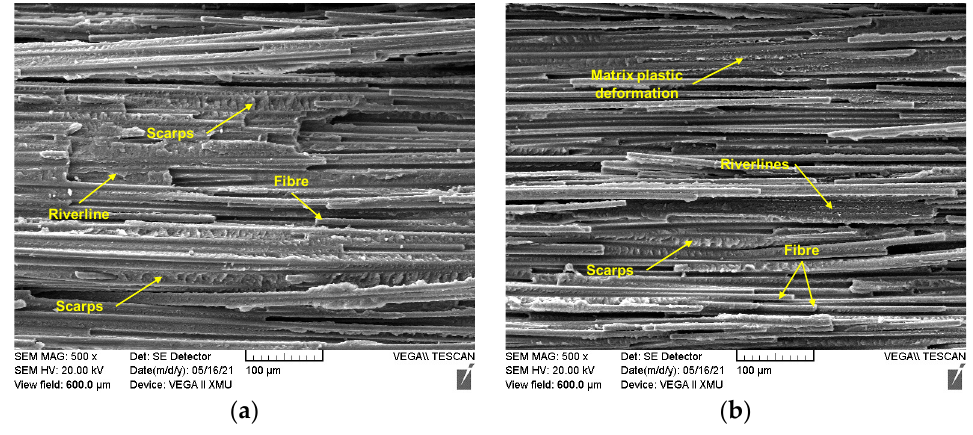
Figure 13. Fracture surface morphology of different off-axis tension specimens: ( a ) 75°; ( b ) 90°. The fractographic study of the off-axis specimens shows that under a small off-axis angle of 15°, a high level of shear stress led to shear plastic damage of the matrix, and the fibres limited the material deformation. For specimens with off-axis angles of 30°, 45° and 60°, the tension and shear combined stresses promote the damage process in the matrix.